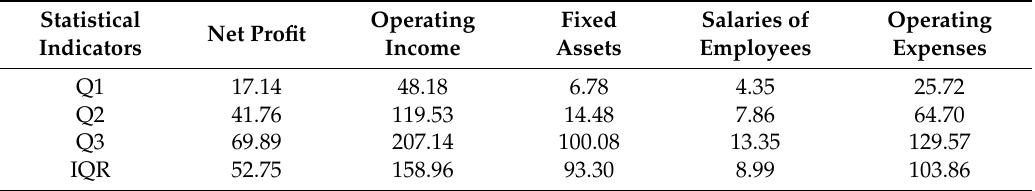
Table 12. The statistical indicators of the box plot methodology 1 .